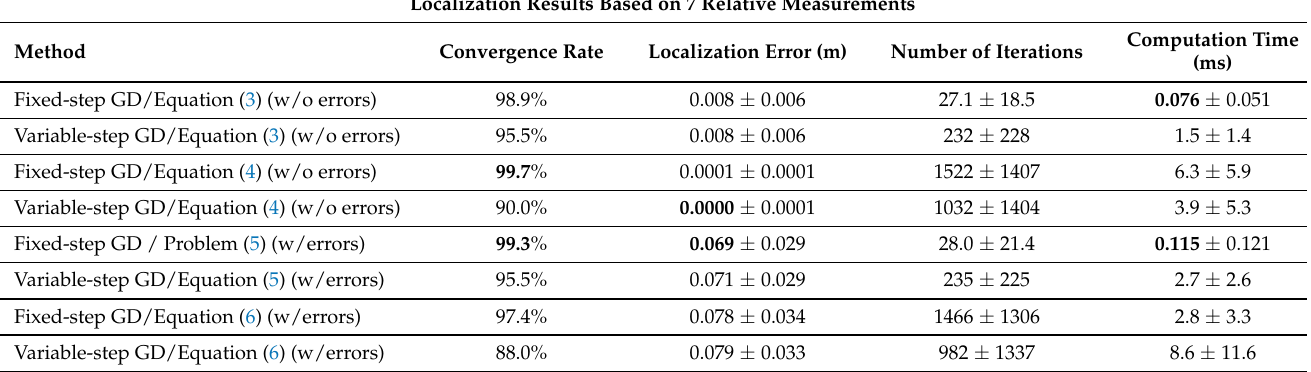
Table 5. Comparative localization results using the different formulations of the estimation problem based on 7 relative measurements, with and without taking into account uncertainty models.